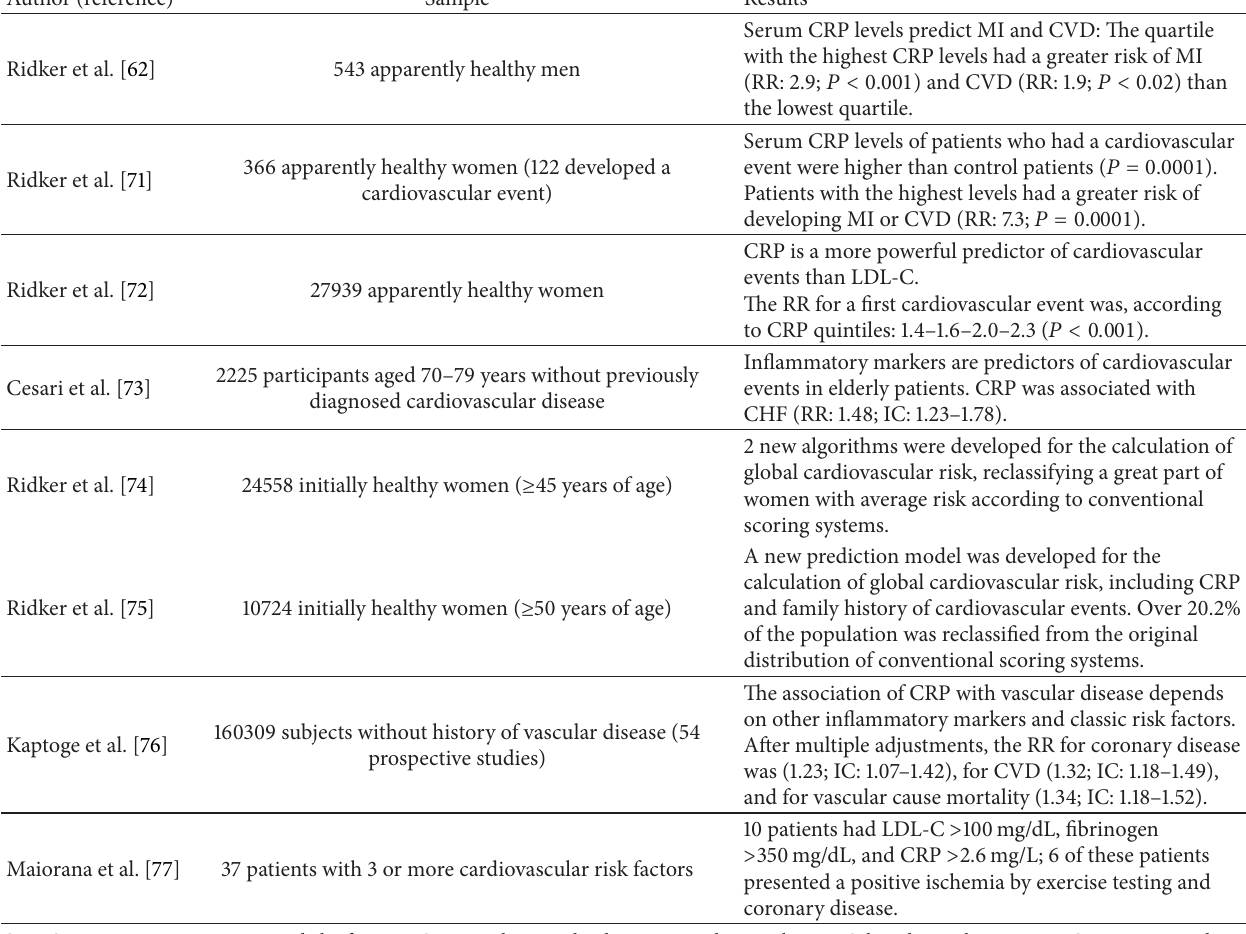
Table 3: Studies on cardiovascular risk assessment utilizing C-reactive